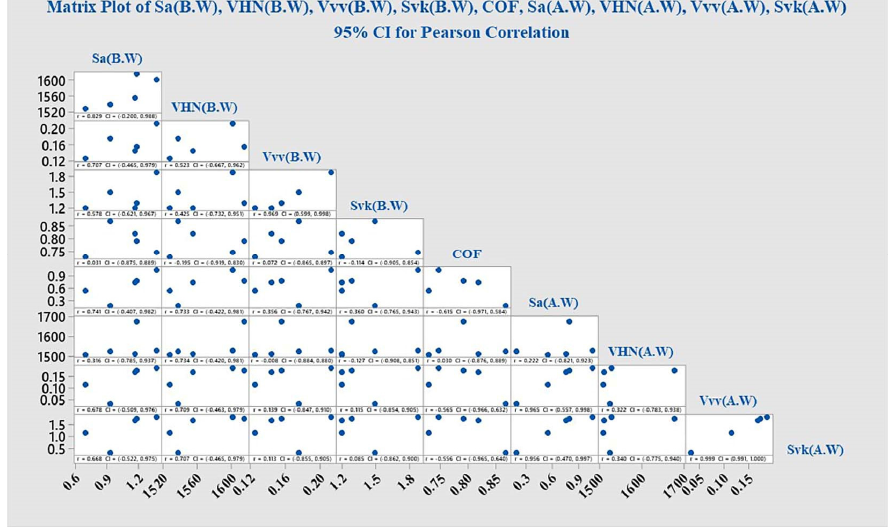
Figure 9. Pearson correlation between the 3 ‐ D parameters (Sa, Svk, Vvv), hardness (HVN), and COF, before and after wear.